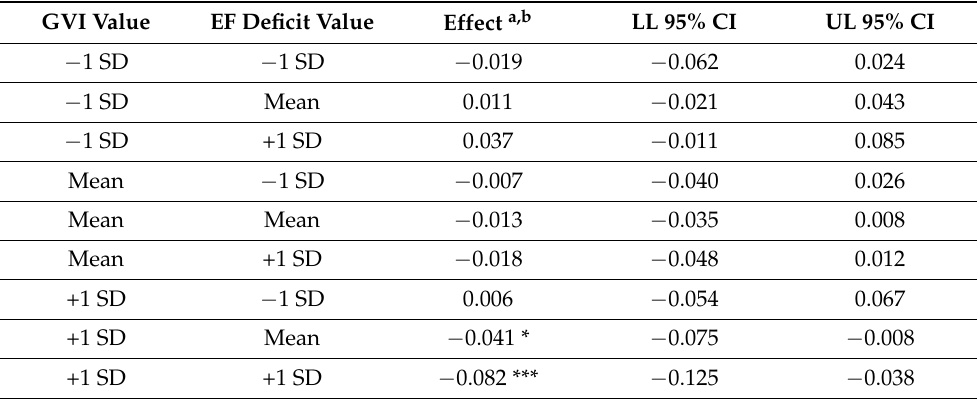
Table 4. Conditional effects of peer network health on substance use at the mean and +/ − 1 standard deviation of GVI and EF deficit